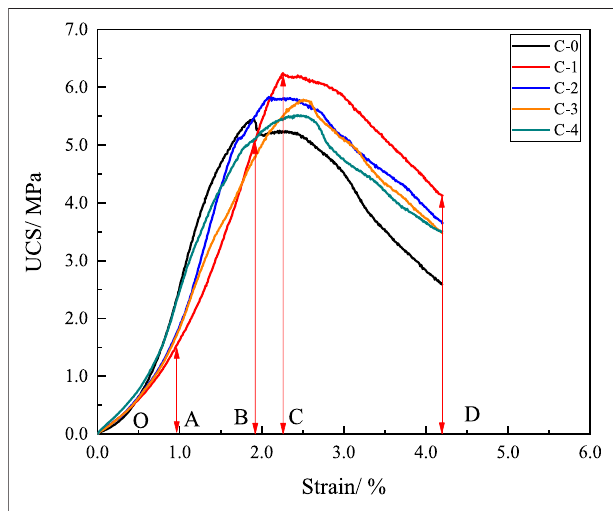
FIGURE 9 | Stress-strain curves of the UCS of CTB and ARSCTB.